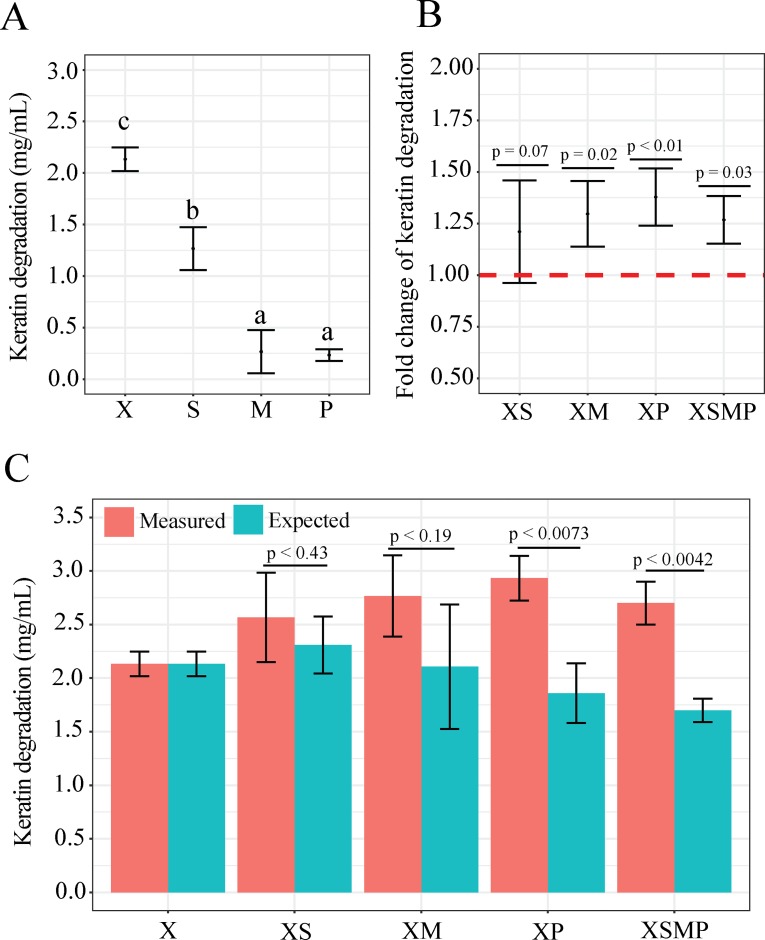
Keratin degradation by mono- and co-cultures.S. rhizophila, X. retroflexus, M. oxydans and P. amylolyticus are represented by the letters S, X, M and P, respectively. Co-cultures are represented by letters signifying its single species constituents, e.g. XS represents the co-culture of X. retroflexus and S. rhizophila. Error bars represent standard deviation of three biological replicates. A) Keratin degradation (mg/mL) for mono-species cultures after 4 days of incubation. Different letters define statistical grouping (ascending order, padj < 0.05, Lin.1) B) Fold increase of keratin degradation in co-cultures of X. retroflexus, compared to the X. retroflexus mono-culture (indicated by dotted red line). Statistical difference is inferred by Lin.3. C) Measured and theoretical keratin degradation (mg/mL) in the X. retroflexus mono-culture and co-cultures. ‘Measured’ refers to the measured keratin degradation, whereas ´expected´ refers to the expected theoretical amount of keratin degraded by the given co-culture. The expected amount was calculated as follows: Expected XS co-culture degradation = Degradation potential of X. retroflexus in mono-culture per CFU * CFU count of X. retroflexus in XS co-culture + degradation potential of S. rhizophila in mono-culture per CFU * CFU count of S. rhizophila in the XS co-cultures. For convenience a complete calculation of the XS co-culture has been added as S12 Fig. Significant difference was inferred by a two-tailed independent two-sample t-test.